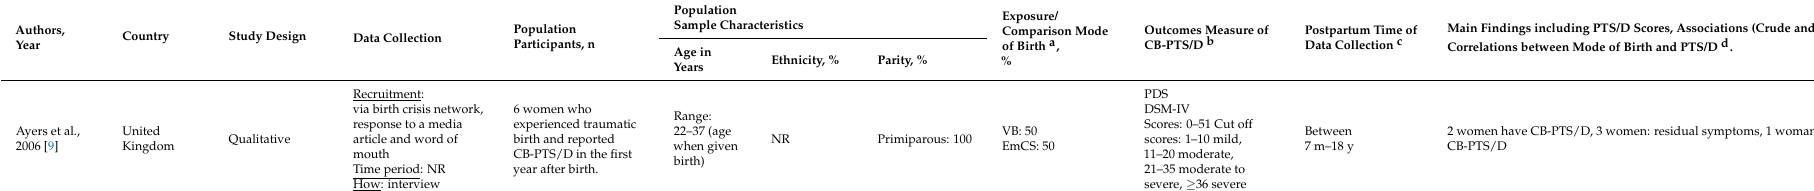
Table 1. Overview of included studies in the integrative